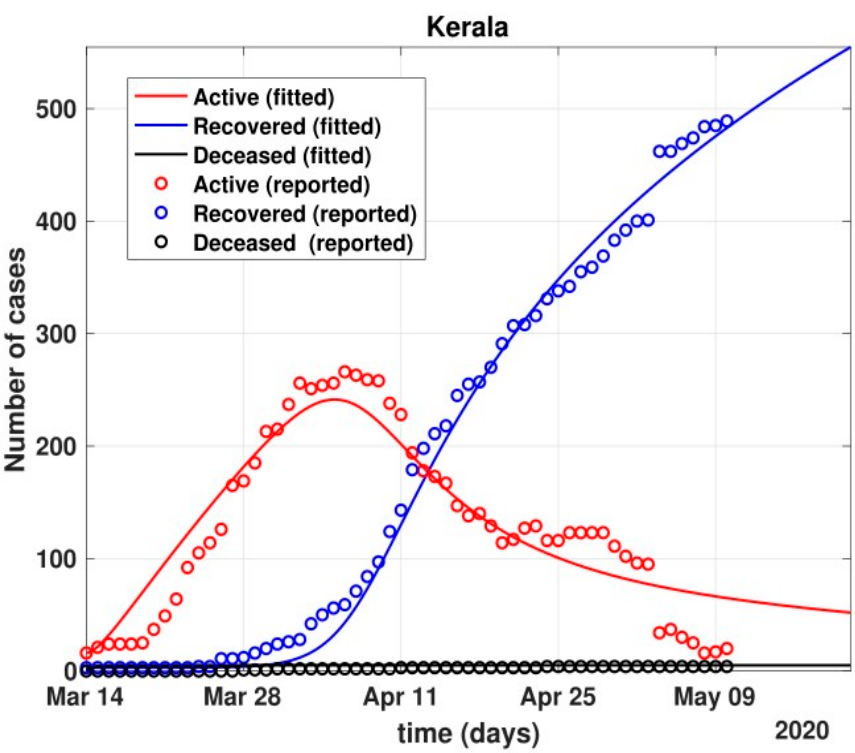
Figure 15. Fit of the proposed model (1) for the number of COVID-19 cases in Kerala.